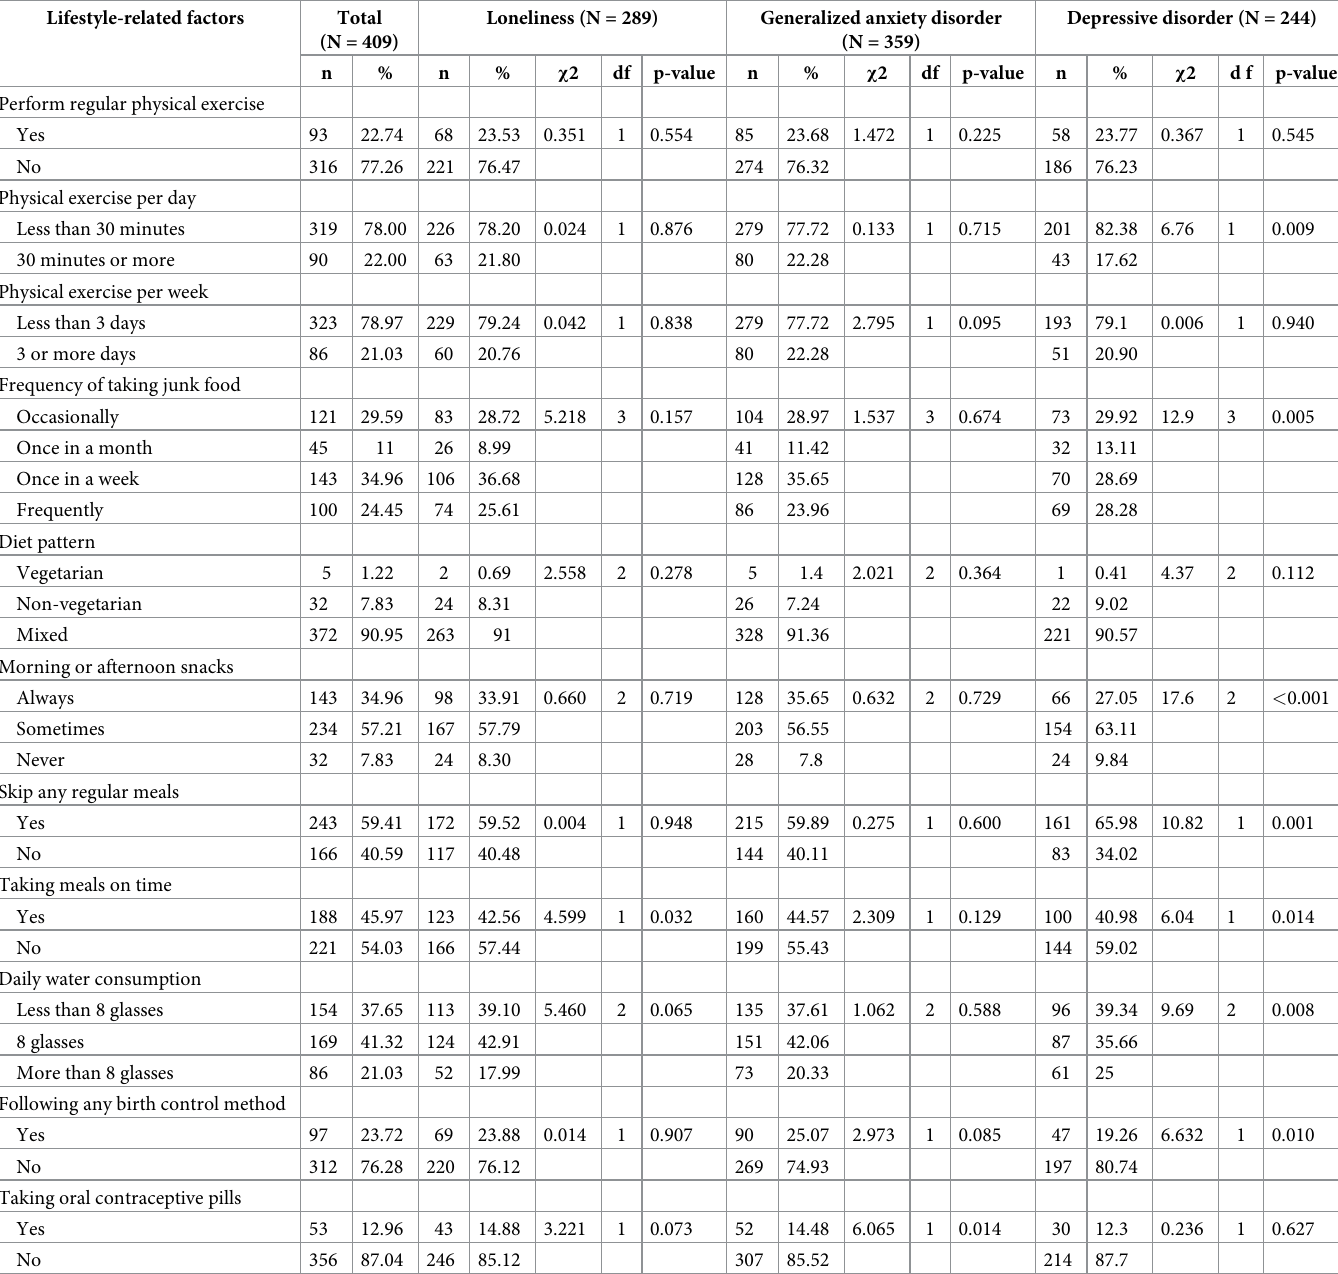
Table 2. Distribution of lifestyle-related factors and their association with mental health problems among the patients suffering from polycystic ovarian syndrome. Lifestyle-related